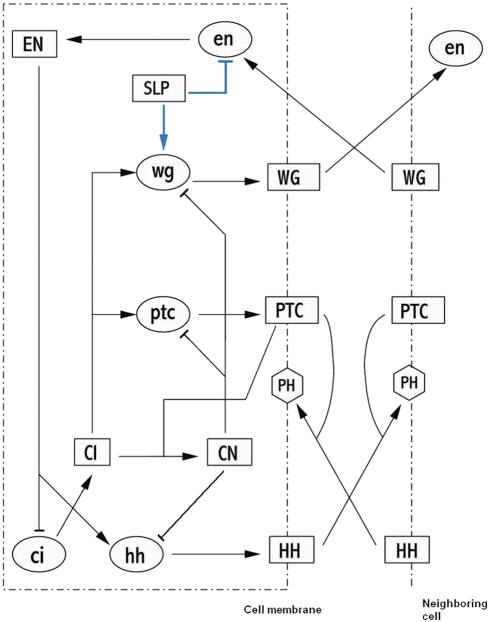
Segment polarity regulatory network including sloppy-paired protein.In this model, the possibility of Wg autoactivation and en repression by CN is not included.